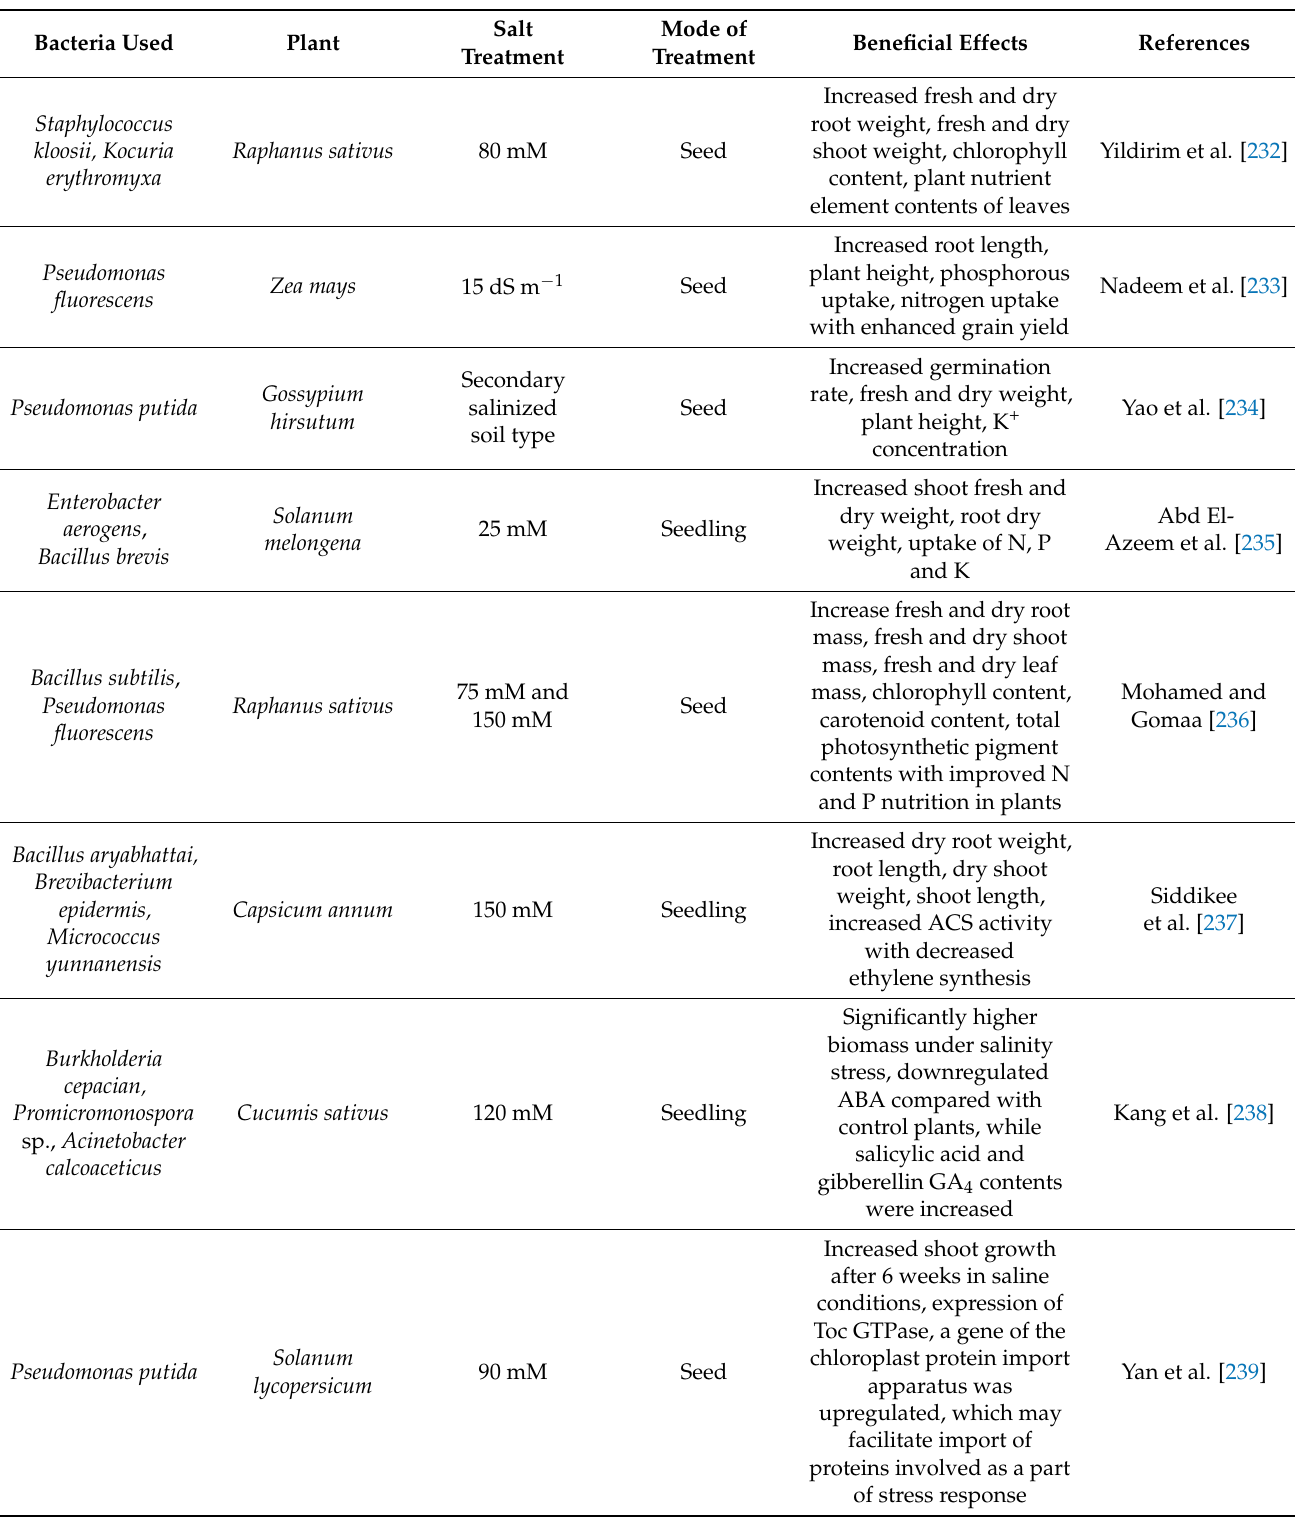
Table 1. PGPR mediated induction of salinity stress in